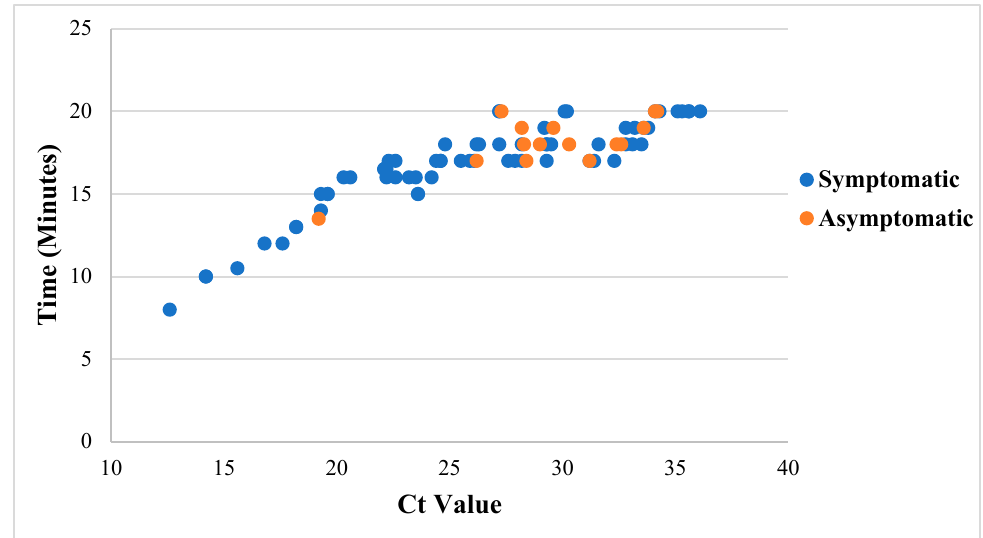
Figure 4. Distribution of Ct values (RT-PCR) against time-to-positivity (Lucira). The blue dots represent samples of symptomatic patients and the orange dots represent samples of asymptomatic patients.